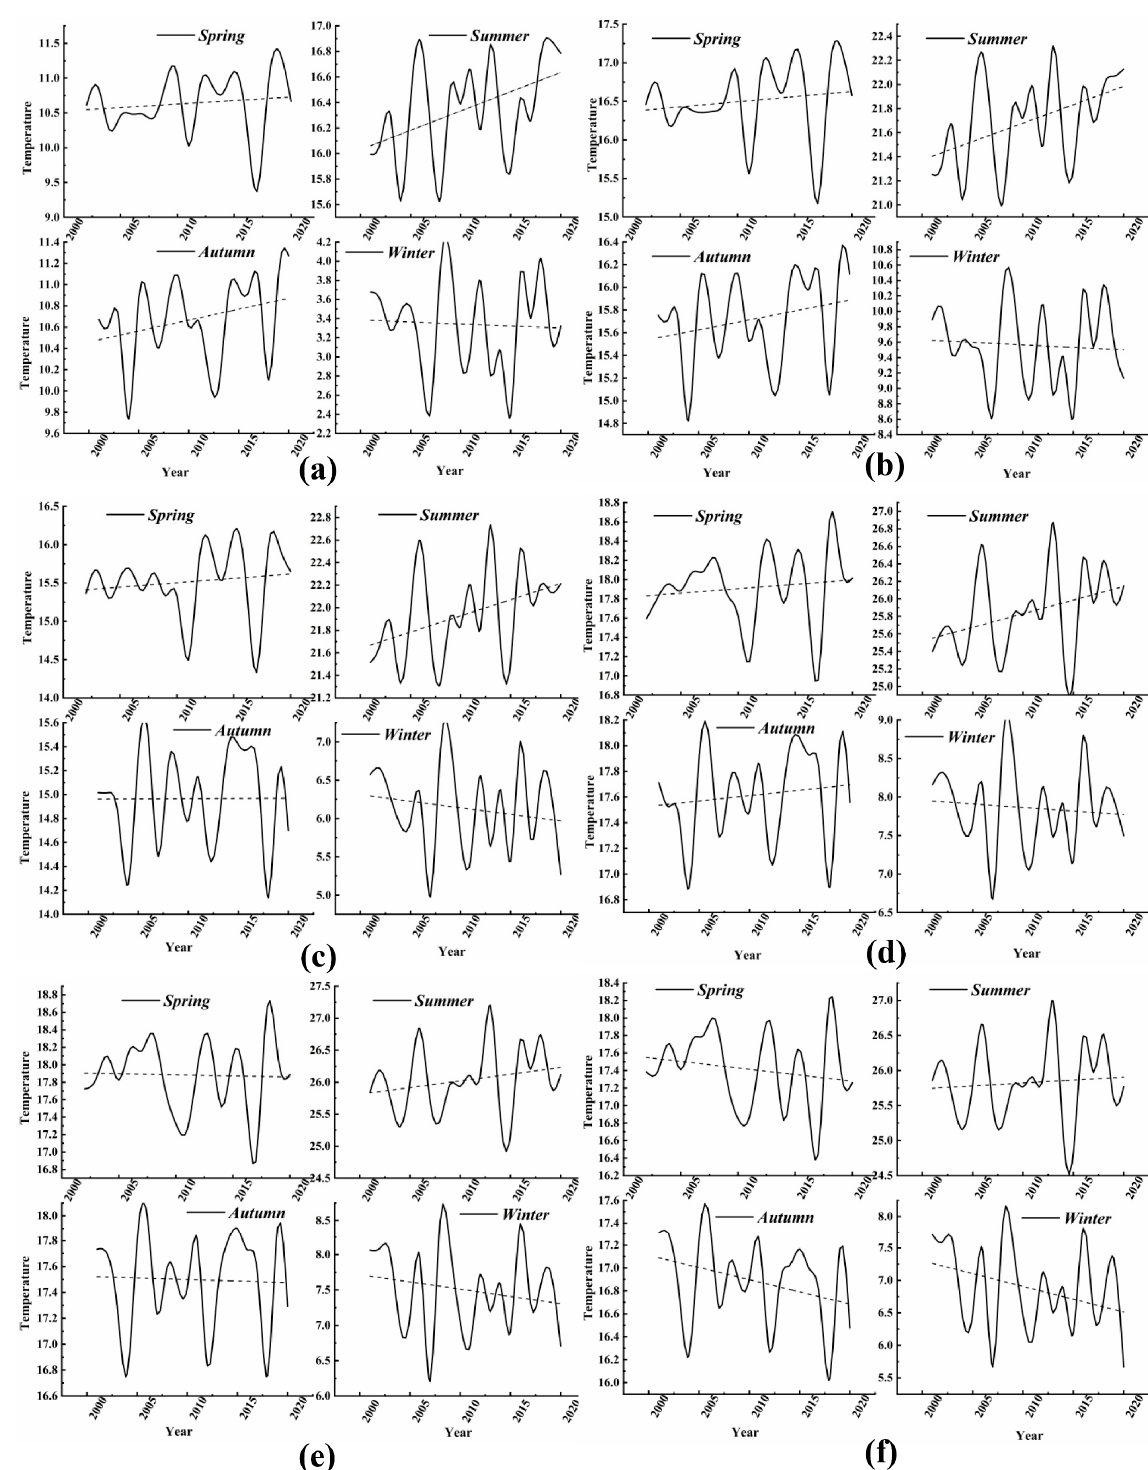
Figure 12. Seasonal characteristics of the temperature variation in the study area ( ℃ ). ( a ) Lugu Lake; ( b ) Qionghai Lake; ( c ) Ma Lake; ( d ) Three Forks Lake; ( e ) Luban Reservoir; ( f ) Shengzhong Reservoir. Note, the direction of the dashed line indicates the trend of temperature in spring, summer, autumn and winter.